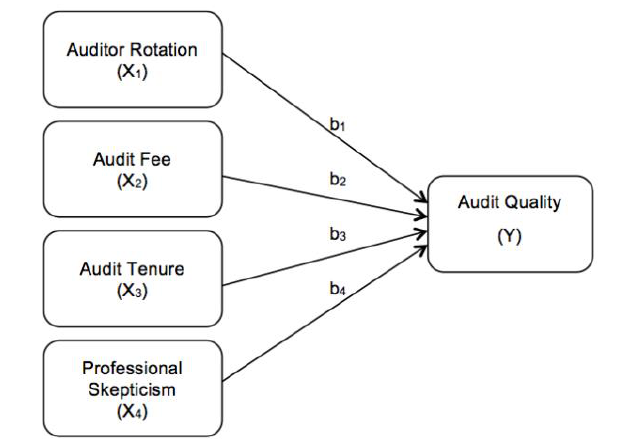
Figure 1: Conceptual Model